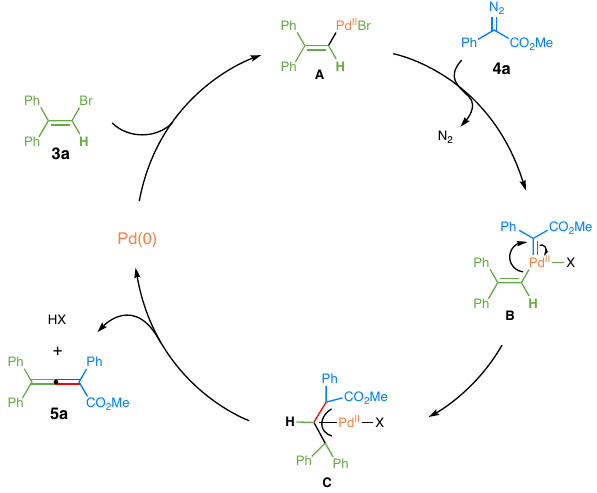
Fig. 8 Plausible reaction mechanism. X = Br or OAc; ligands are omitted for